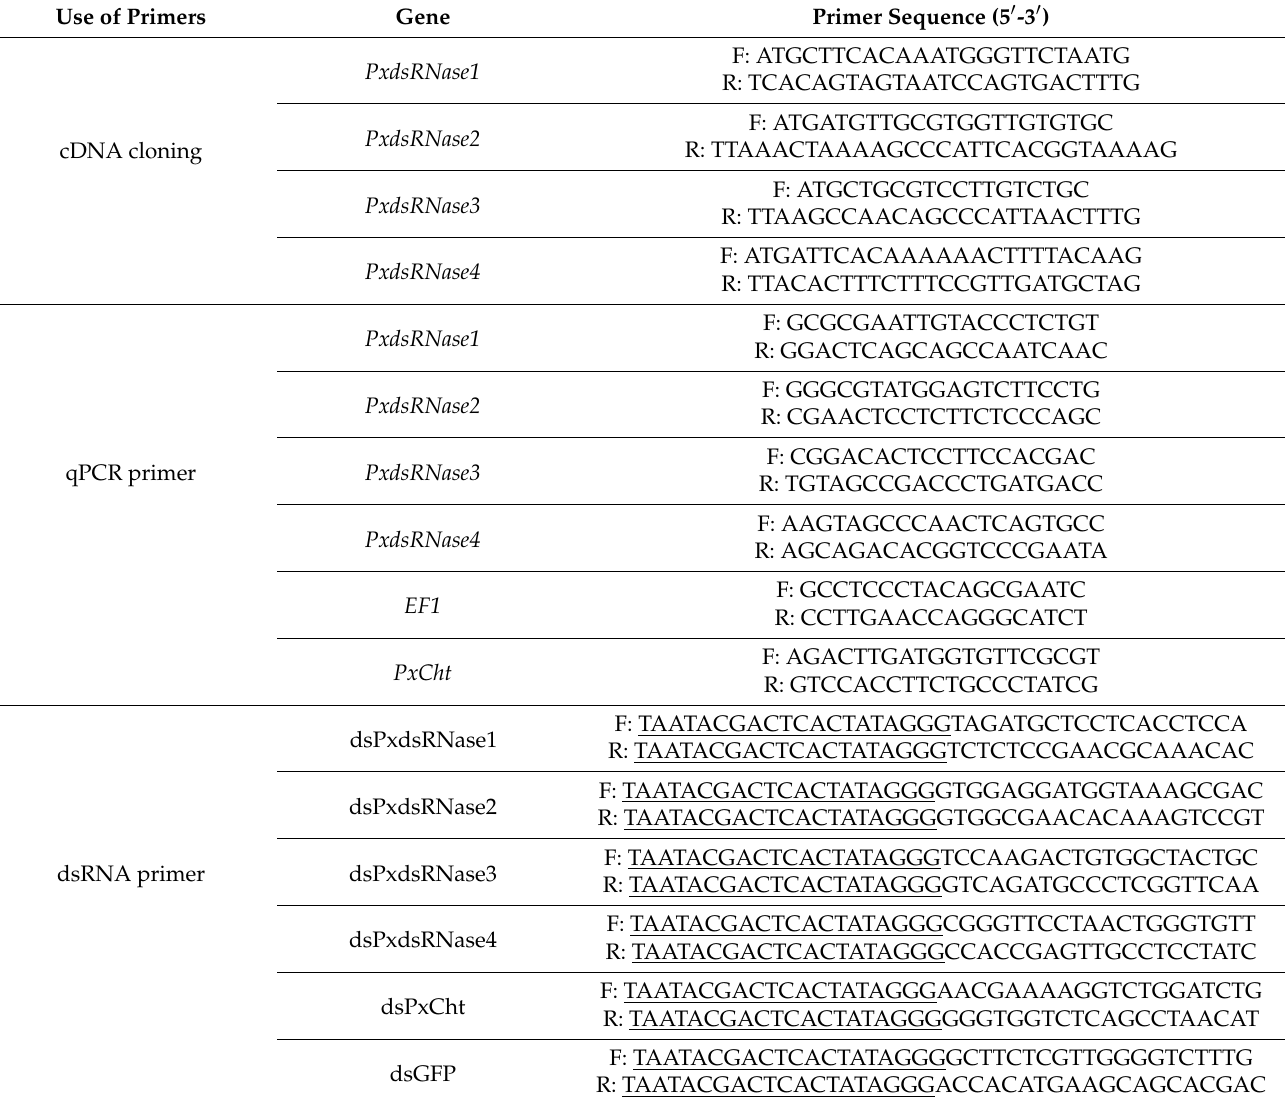
Table 1. Primers used in the